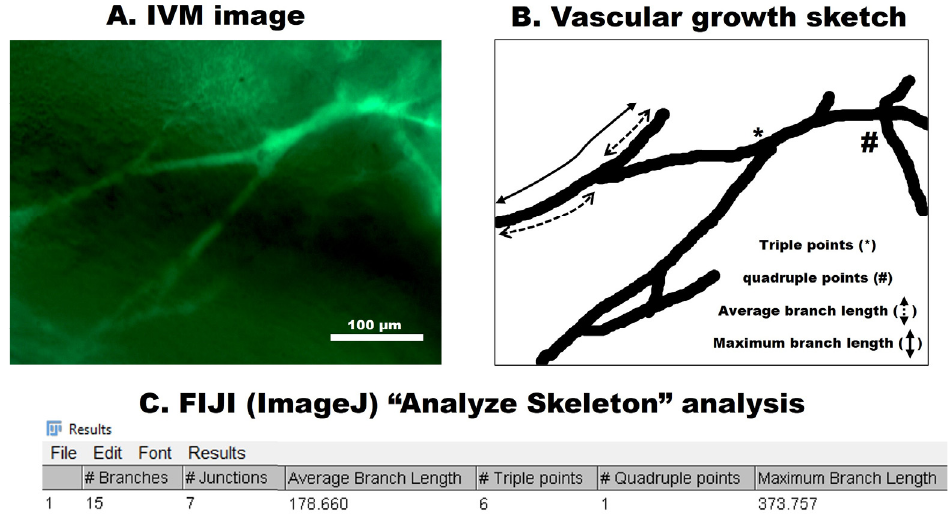
Figure 3. Analysis of the IVM images. ( A ) A representative IVM image (HPF) showing fluorescent microvessels. ( B ) An overlay micrograph (vascular growth sketch) of the IVM image prepared using GIMP software. ( C ) Representative results of vascular growth sketch analysis in Fiji-ImageJ using the “Analyze Skeleton” plugin. Scale bar 100 μ m.